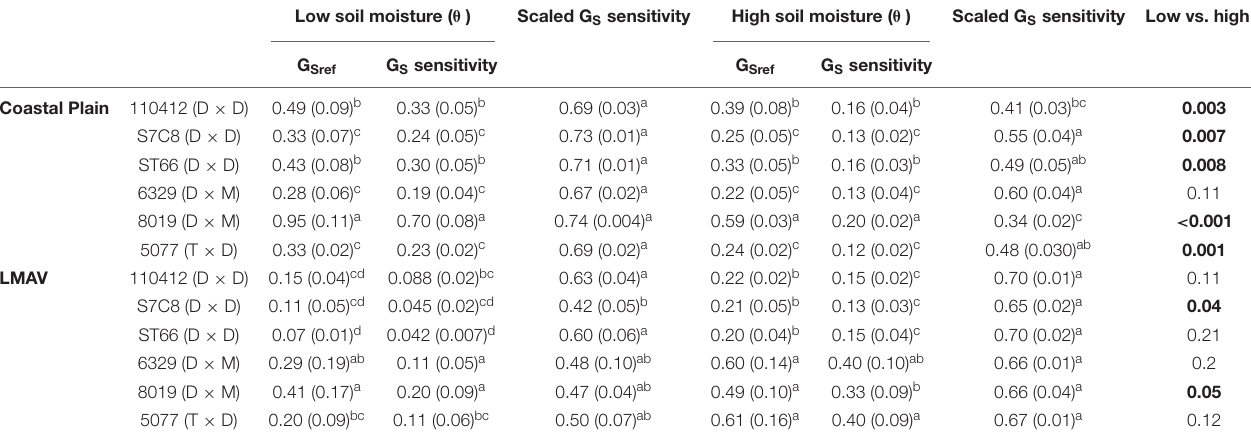
TABLE 3 | Parameters for varietals growing in the Coastal Plain and LMAV sites estimated from linear relationships between canopy stomatal conductance (G S ) and the natural log of vapor pressure deficit (lnVPD; Figure 3 ) estimated under low vs. average to high soil moisture ( θ ; cm 3 cm − 3 ) conditions including G Sref (mol m − 2 s − 1 ; y-intercept; or G S when VPD = 1 kPa), G S sensitivity (mol m − 2 s − 1 ln kPa − 1 ; slope of line) and scaled G S sensitivity